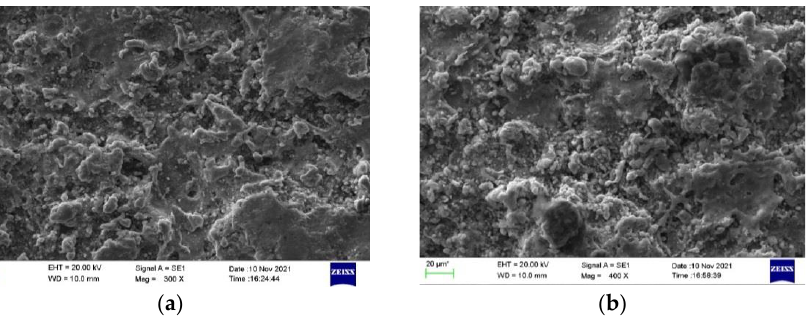
Figure 6. Surface morphology of D71 valve plates. ( a ) Surface morphology of ordinary plate; ( b ) Surface morphology of high-gradient plate